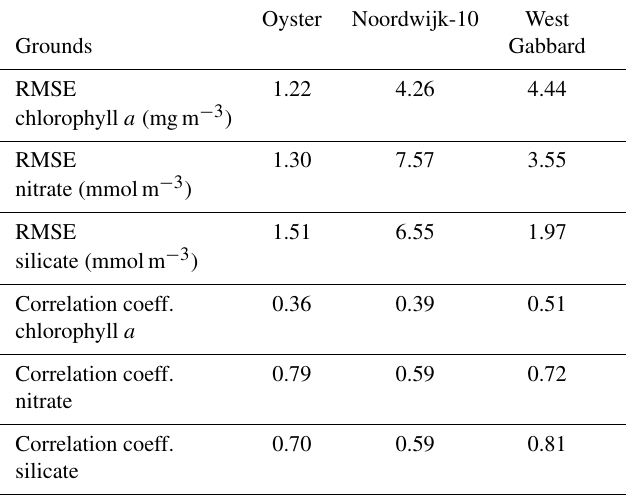
Table 3. The RMSE and correlation coefficient, after tuning, be- tween the modelled and observed time series for chlorophyll a , ni- trate and